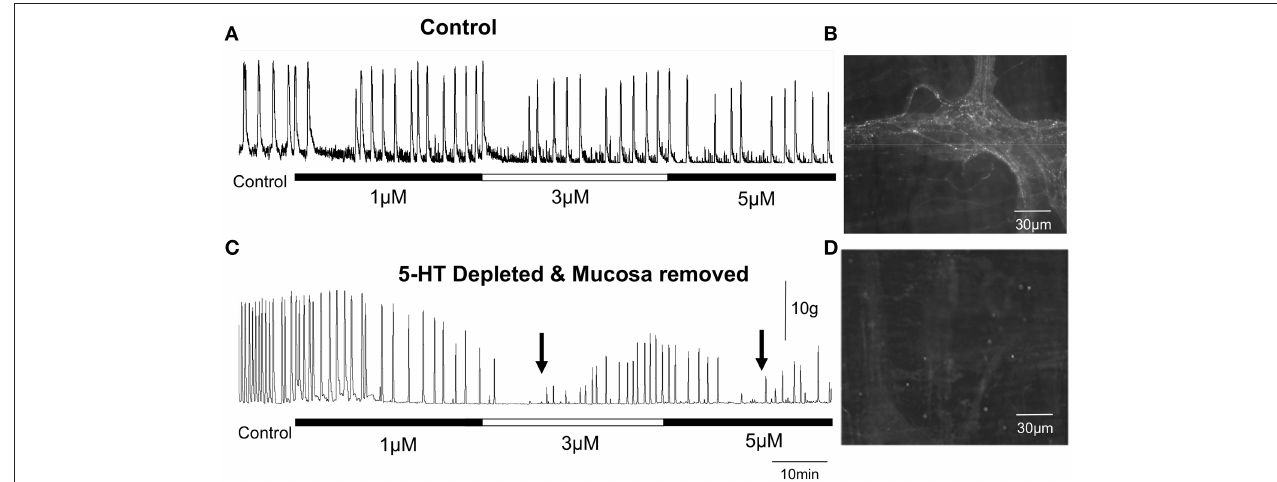
FIGURE 2 | Repetitive peristaltic contractions evoked by maintained colonic distension with a fixed artificial fecal pellet are only temporarily inhibited by 5-HT3 and 5-HT4 antagonists in isolated guinea-pig distal colon. (A) Shows that increasing concentrations of ondansetron and SDZ-205-557 have only temporary effects on inhibiting distension-evoked peristaltic contractions in control distal colon. (B) Shows 5-HT is present in varicose nerve axons of myenteric ganglia. (C) In reserpine-treated guinea-pigs to deplete neuronal 5-HT and which also have their mucosa and submucosal plexus removed, maintained colonic distension by a fecal pellet continues to evoke repetitive peristaltic contractions. Simultaneous addition of increasing concentrations of ondansetron and SDZ-205-557 temporarily inhibited peristaltic contractions, which recovered in the continued presence of both antagonists. The two black arrows indicated when peristaltic contractions recover in the presence of both antagonists when applied at 3 µ M and then 5 µ M. (D) Reserpine treatment depleted all neuronal 5-HT from this